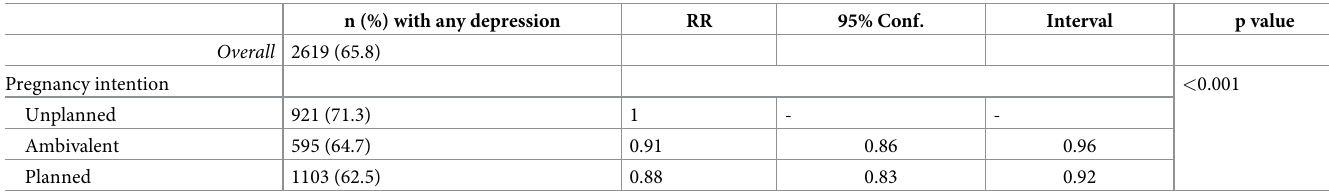
Table 2. Univariate regression of pregnancy intention and any symptoms of